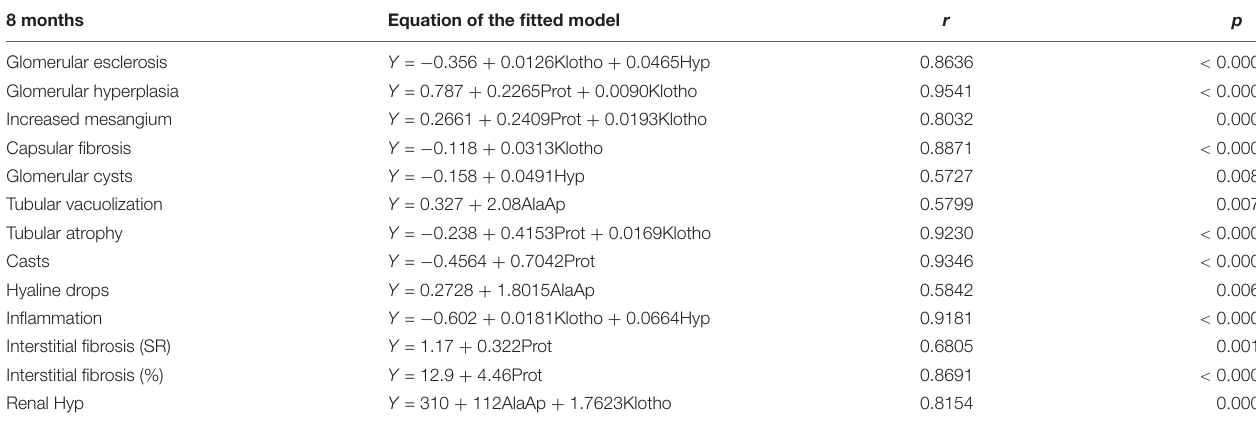
TABLE 7 | Equation of the fitted model, correlation coefficient ( r ) and p -value of the multiple linear regression between urinary markers measured at 8 months and renal lesions at the end of the experiment (8 months old) in Zucker lean and Zucker obese rats ( n =